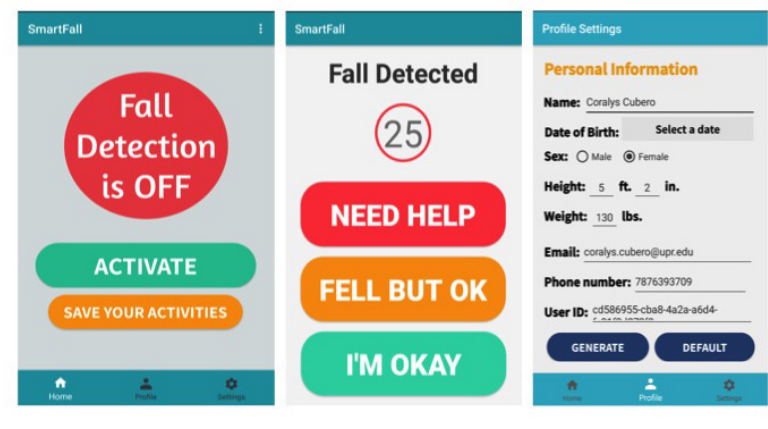
Figure 2. SmartFall User